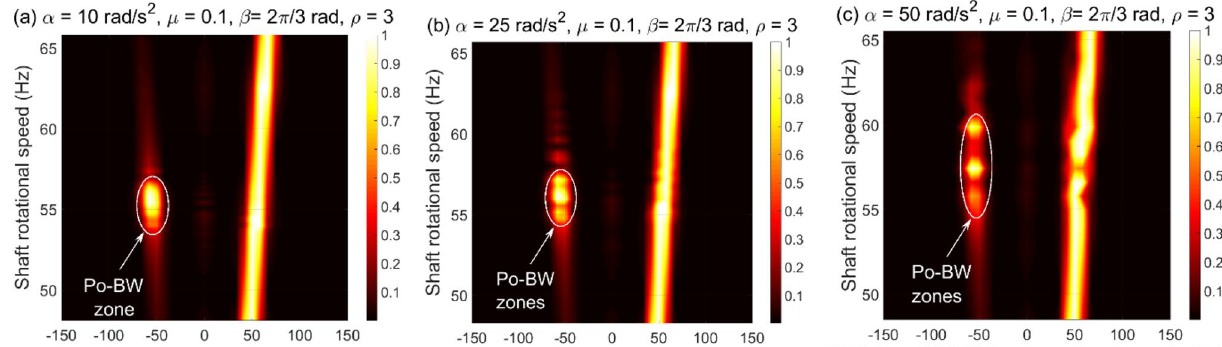
3 rad and ρ = 3 in ( a ) for (cid:31)